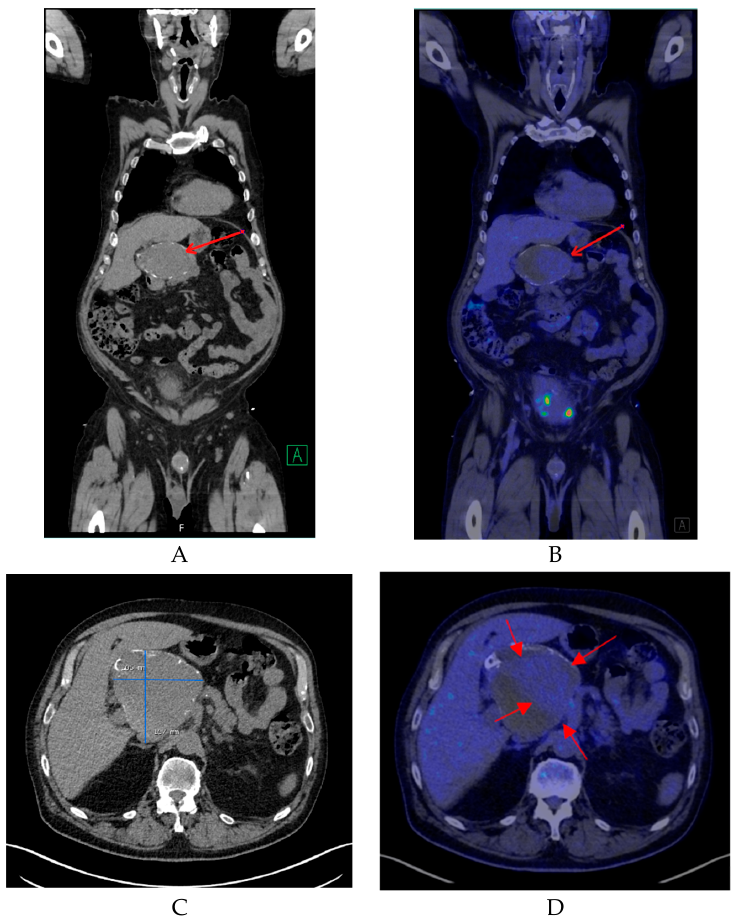
Figure 1. ( A ) A coronal non-contrast enhanced computed tomography (CT) image of the lesion (red arrow). ( B ) A coronal fused positron emission tomography / computed tomography (PET / CT) image showing the same region with mild 18 F-FDG uptake (red arrow). ( C ) A transverse non-contrast CT image confirming the presence of a cyst-like lesion with a hyperdense wall at the hepatic hilum, measuring approximately 107 × 105 mm. ( D ) A transverse fused PET / CT image demonstrating mild surrounding mural